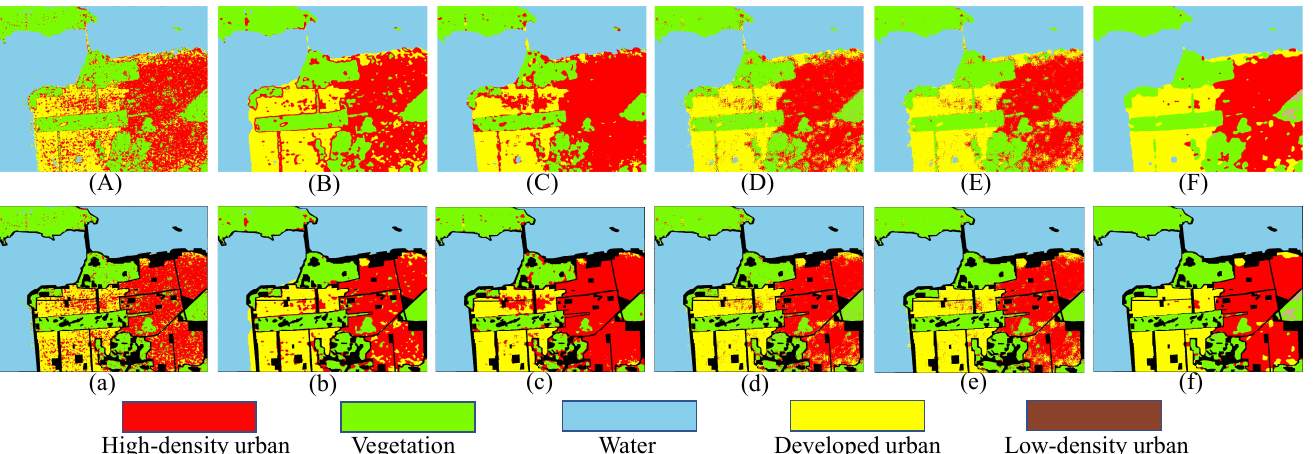
Figure 13. Classification maps of the AIRSAR San Francisco dataset. ( A ) 1D-CNN. ( B ) 2D-CNN. ( C ) DenseNet. ( D ) CapsNet. ( E ) CapsNet-3. ( F ) Proposed method. ( a – f ) are the masked results according to the ground truth of ( A ), ( B ), ( C ), ( D ), ( E ), and ( F ), respectively.